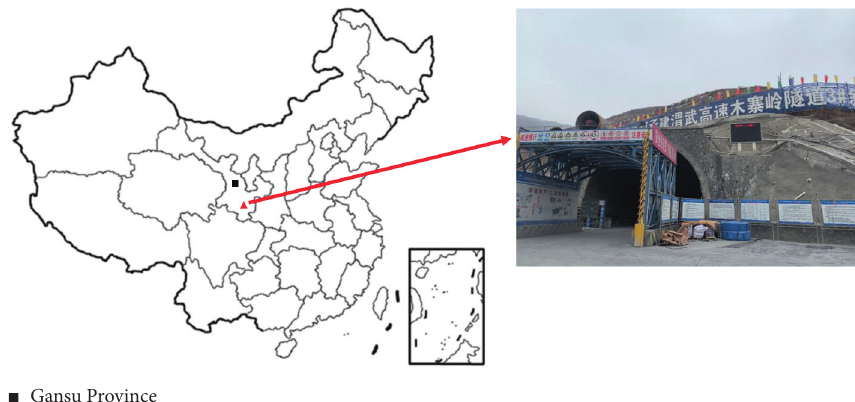
Figure 1: Location of the